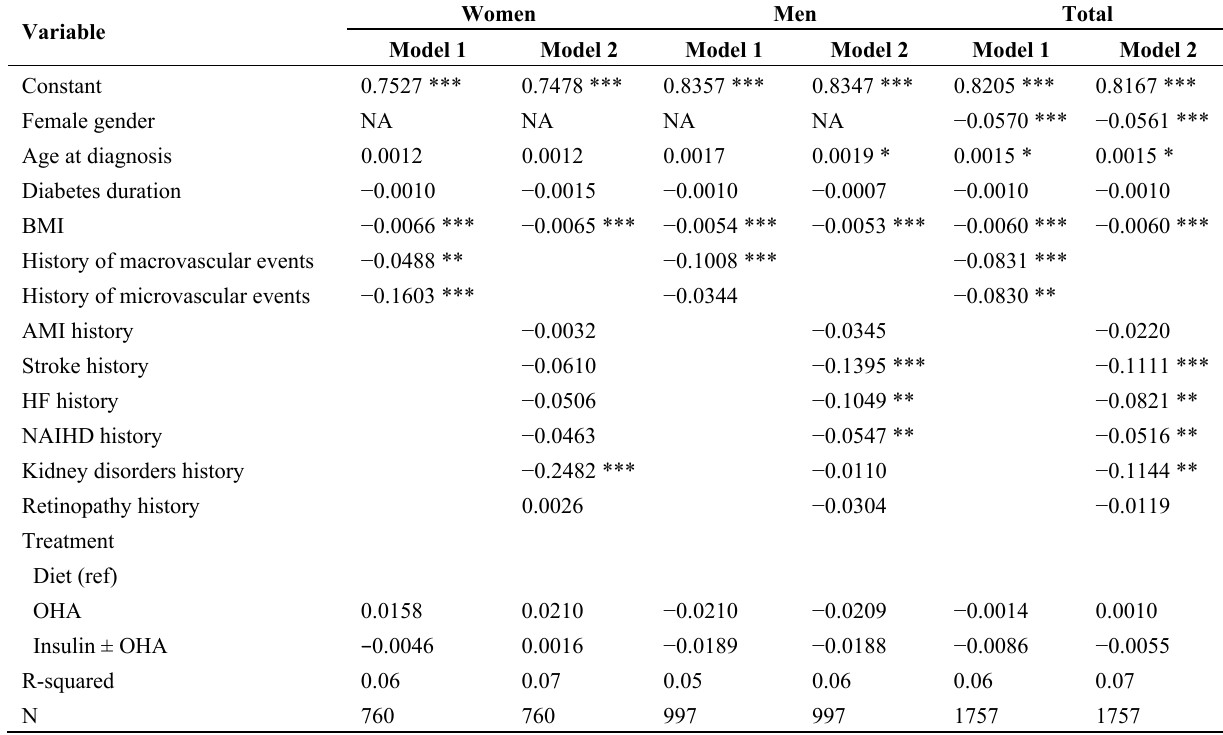
Table 3. Factors associated with variation in EQ-5D score: results from the UK tariff.